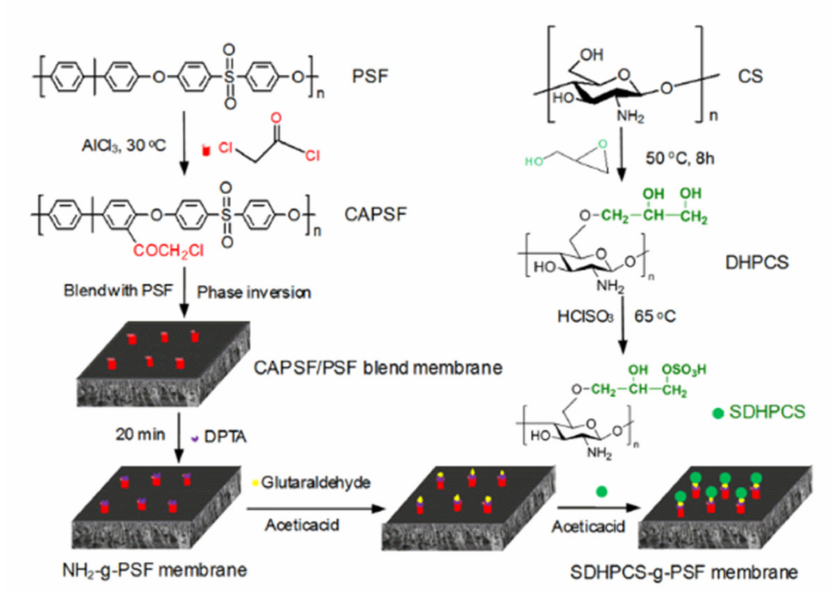
Figure 11. The preparation process of SDHPCS-g-PSF membrane (reproduced with permission after [93], Scheme